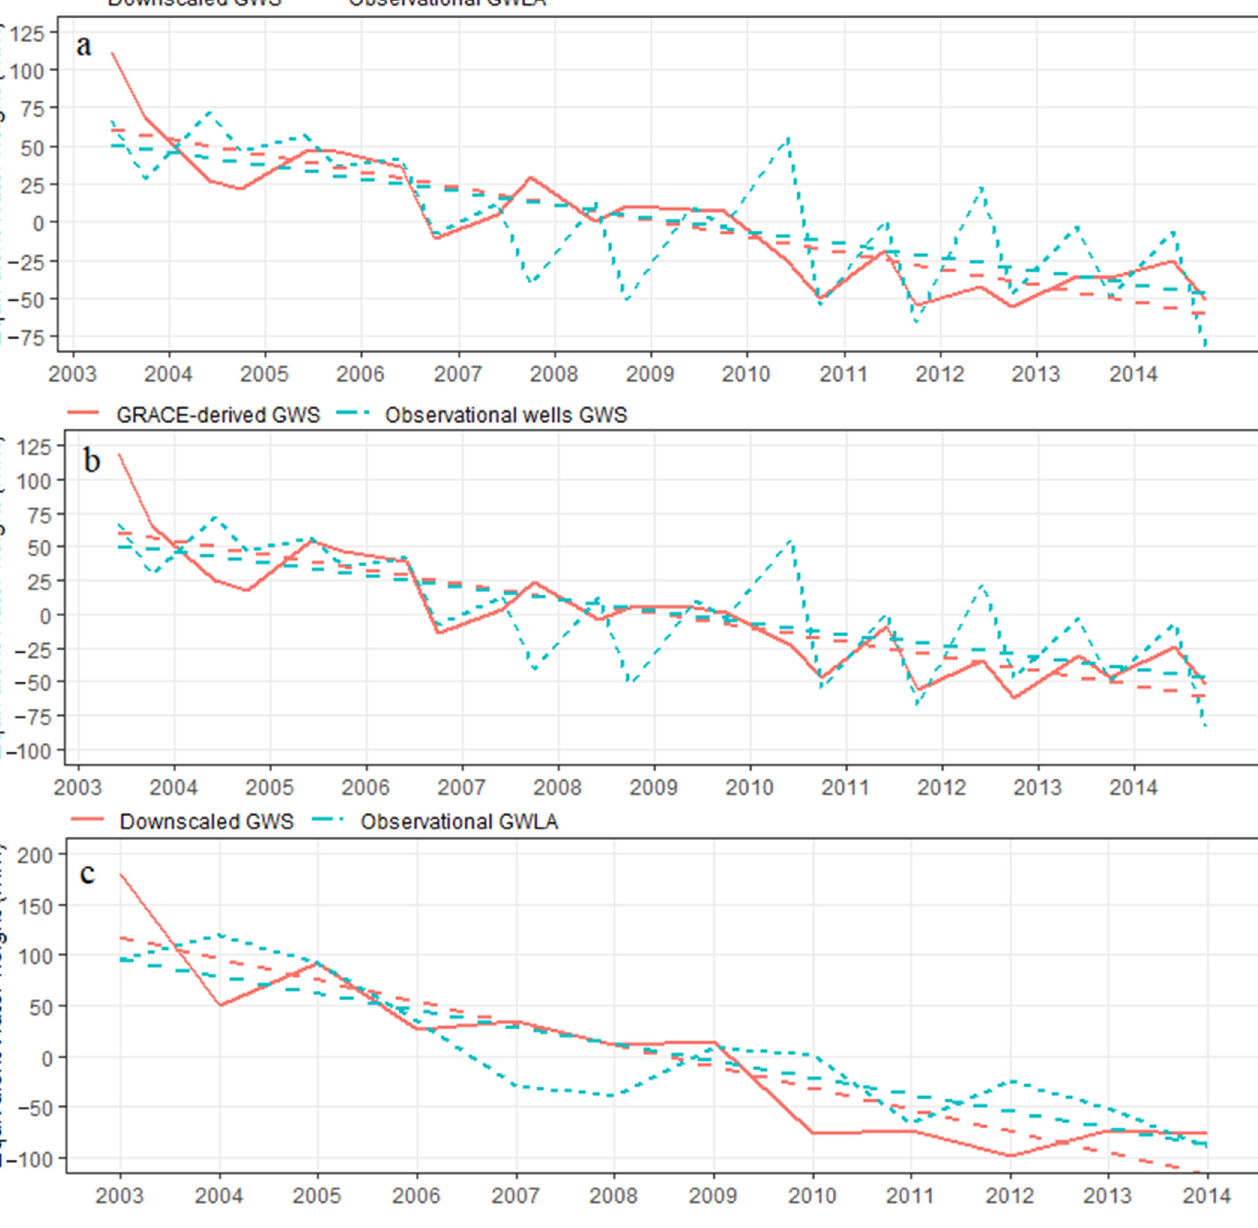
Figure 13. Comparison of observational wells, downscaled, and GRACE-derived GWS time series ( a , b ) at the seasonal scale and ( c , d ) at the annual scale.